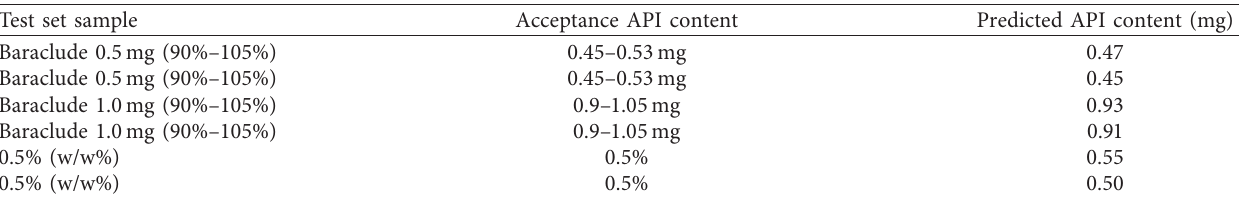
Table 4: The actual and predicted API content and the percentage of predicted API in the drug content calculated by the best performance model. Test set